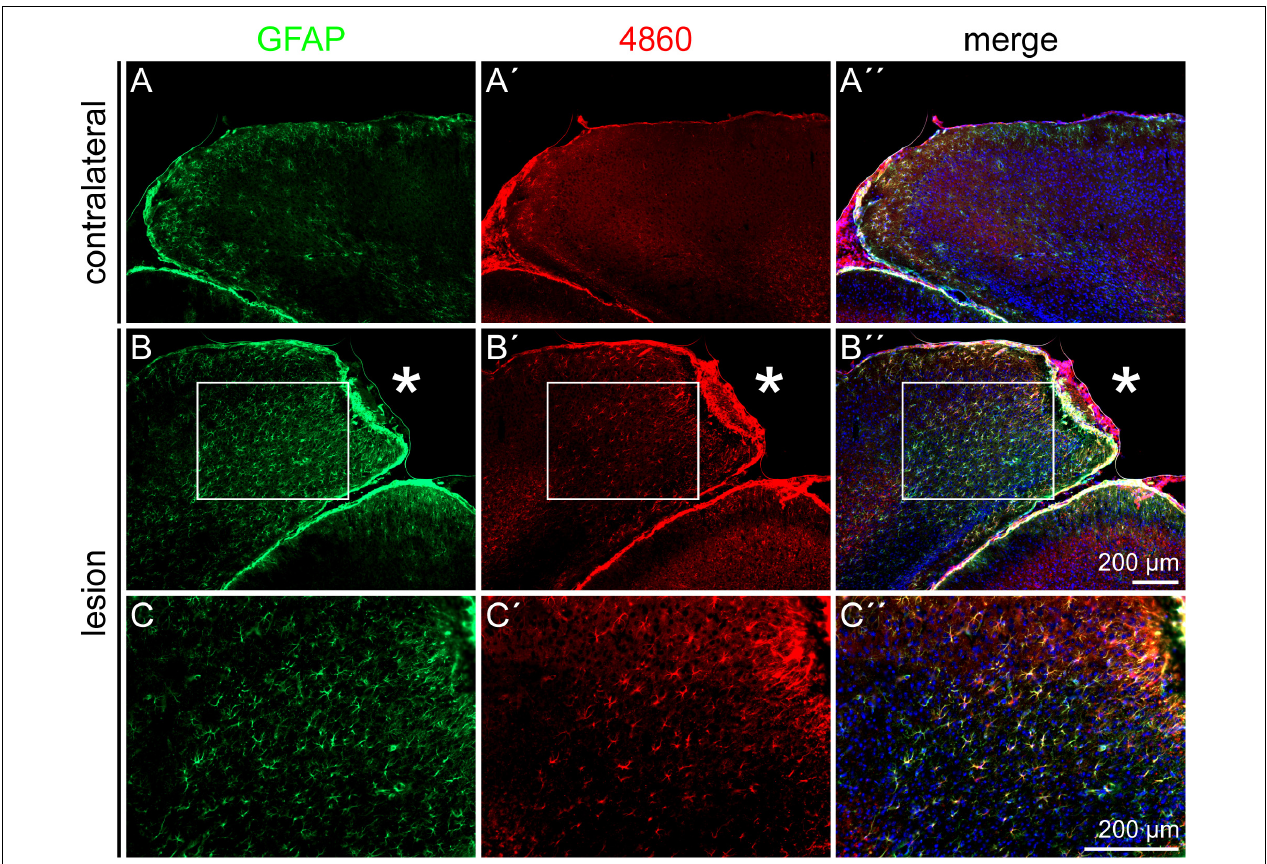
FIGURE 8 | 4860 glycoepitope expression on astrocytes after lesion, 3 dpl. (A–A (cid:48)(cid:48) ) In the contralateral hemisphere, mAb 4860 labeled only few GFAP-positive cells. (B–C (cid:48)(cid:48) ) In contrast, the penumbra was rich in 4860-positive cells, representing a subpopulation of GFAP-positive astrocytes. (C–C (cid:48)(cid:48) ) Higher magnifications of the boxed region in B–B (cid:48)(cid:48) . Asterisk: lesion core; scale bars: 200 µ